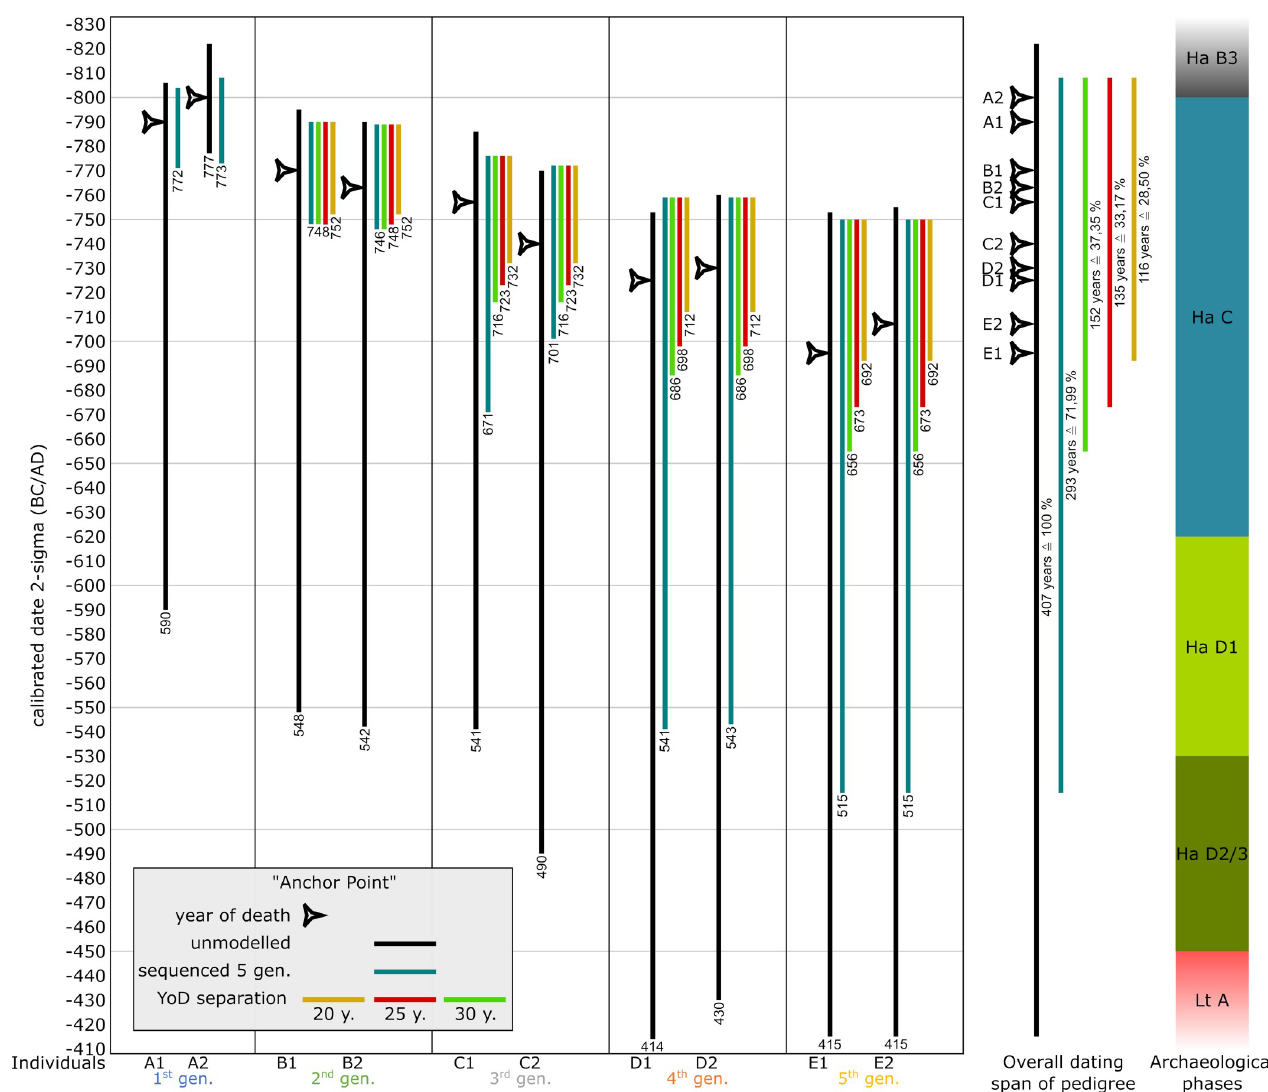
Fig 18. Combining pedigree-based Bayesian modelling and additional constraints. Unmodelled, calibrated date ranges (black) plotted against modelled ranges of simulation runs with 5 generations (blue) of the anchor point simulation. Additional constraints are results of varying YoD separations between individuals from subsequent generations (yellow: 20 years, red: 25 years and green: 30 years). Numbers below vertical bars are endpoints of dating ranges. Triangle symbols depict the actual YoD’s as inserted at the outset of the modelling process. The archaeological phases are based on the relative chronology of southern